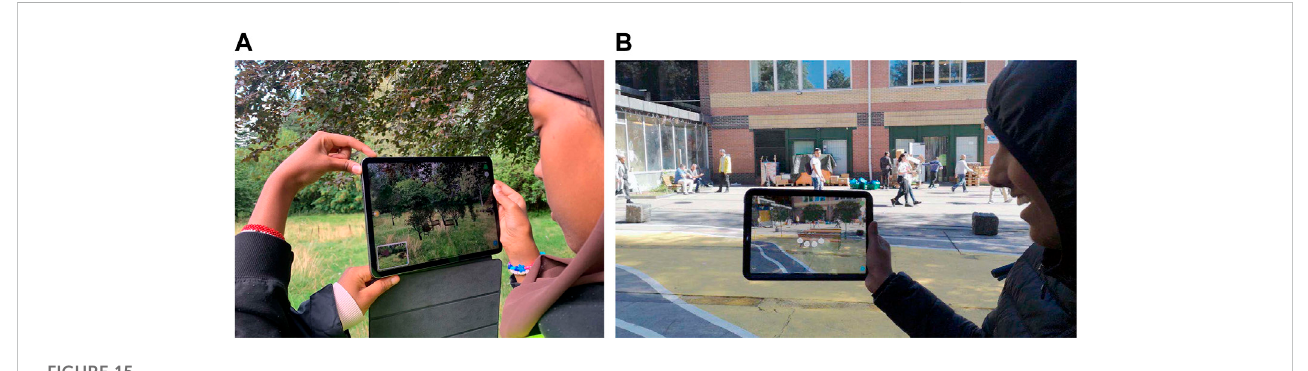
FIGURE 15 Panel (A, B) . Users screenshot a design from a chosen vantage